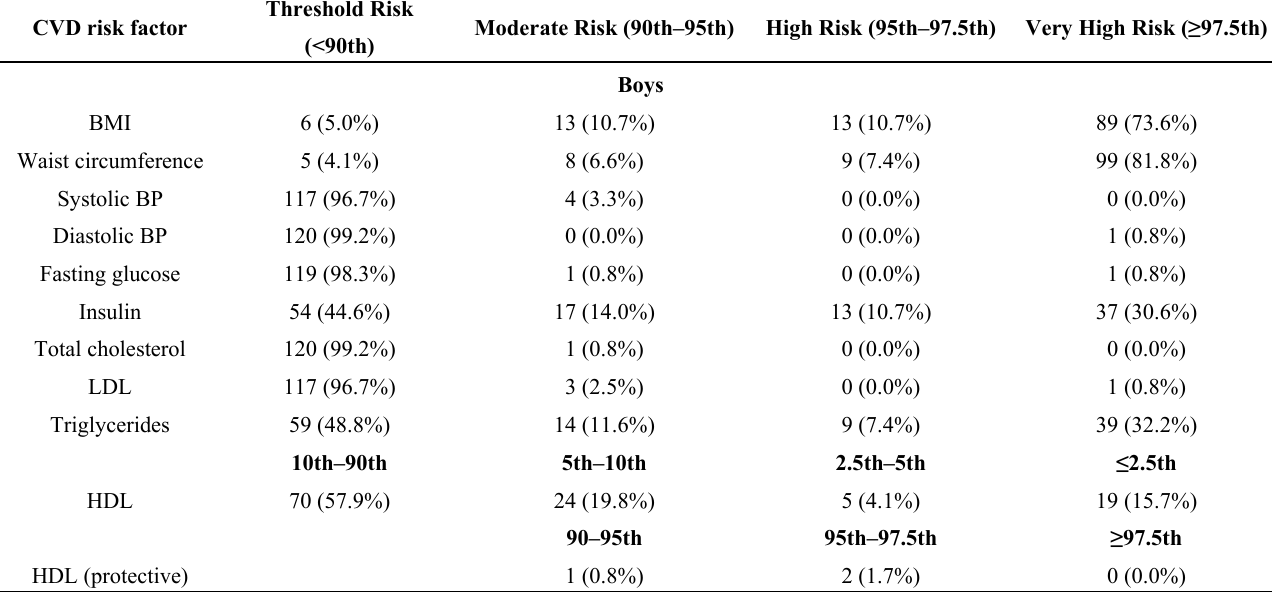
Table 3. Count and percent of observations by CVD risk score factor level and